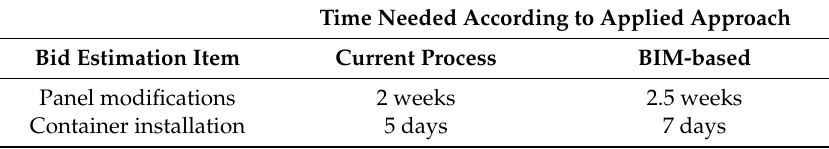
Table 3. Comparison of assembly times: Current process vs.